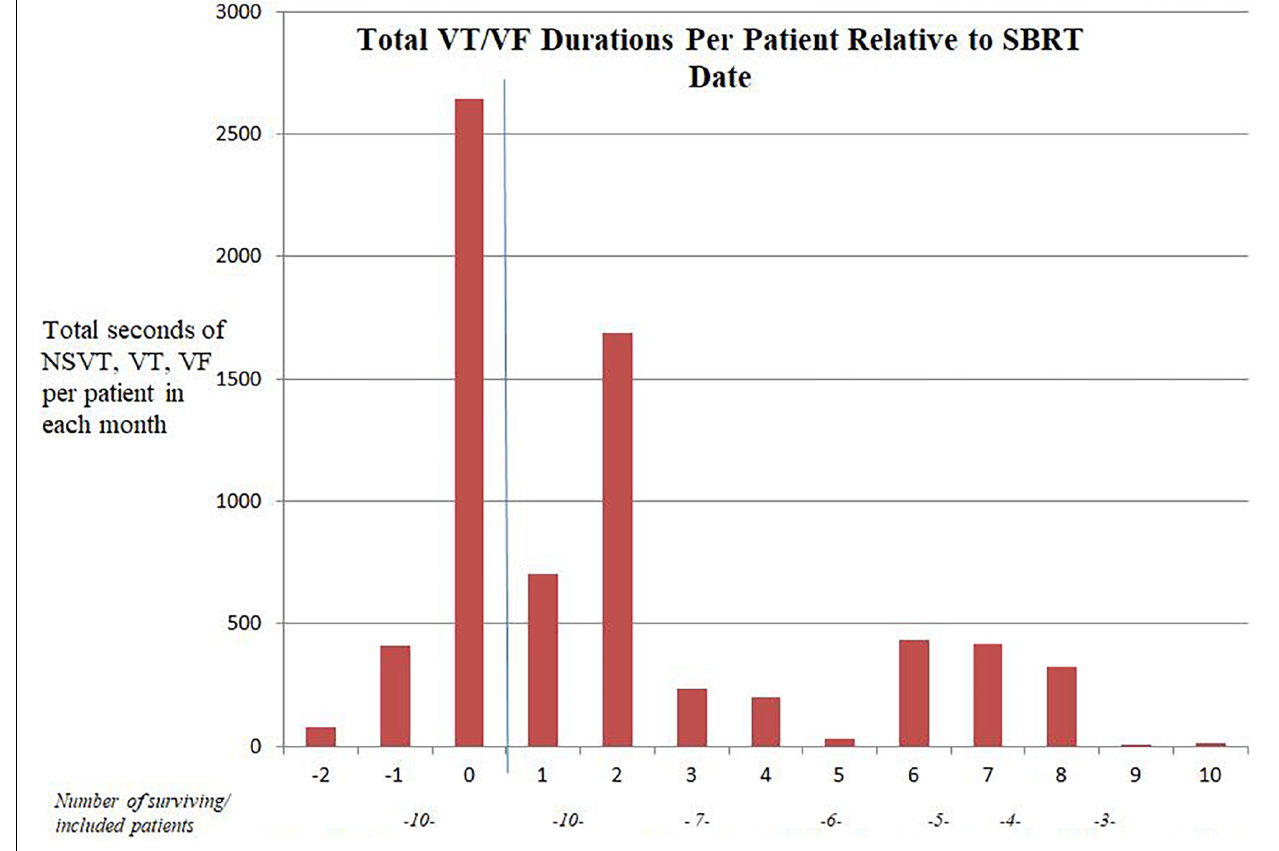
FIGURE 1 | “Month” of follow-up relative to SBRT date. The blue line represents the SBRT date. Three patients had no follow-up ICD data after